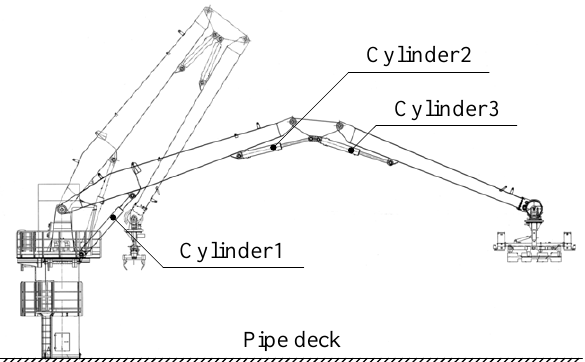
Figure 6: Knuckle boom crane with redundant DOF.